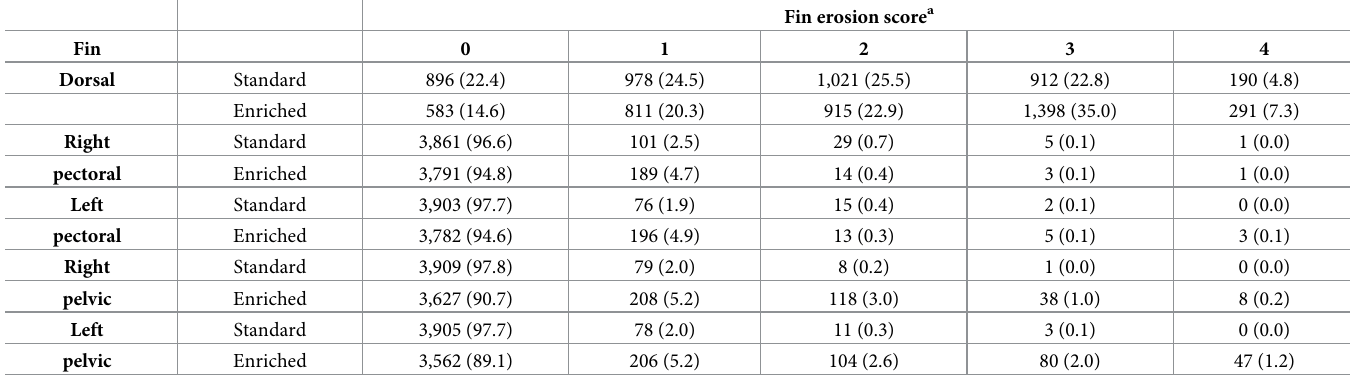
Table 3. Number of 2-summer-old salmon (% in brackets) in standard and enriched rearing groups assigned to each fin erosion category.